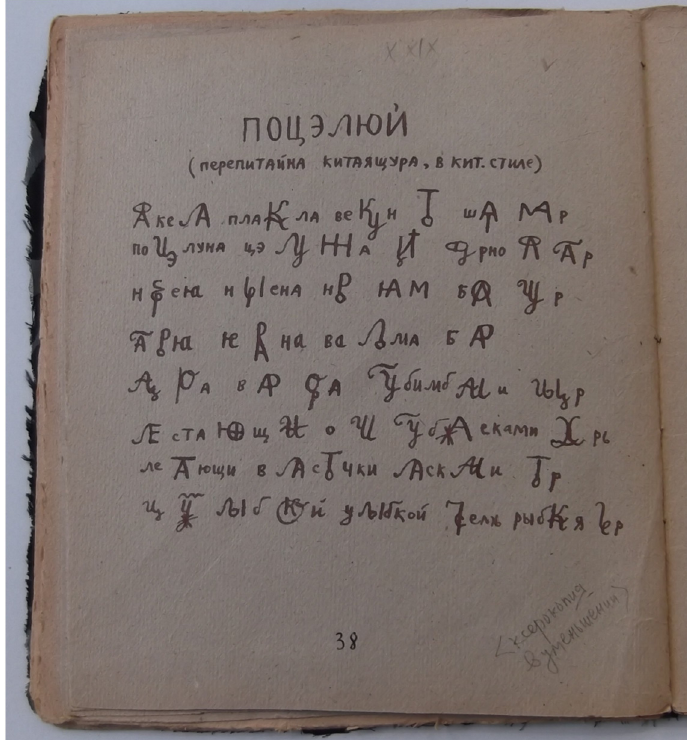
Figure 5. ‘Shedevrez’, p. 31.